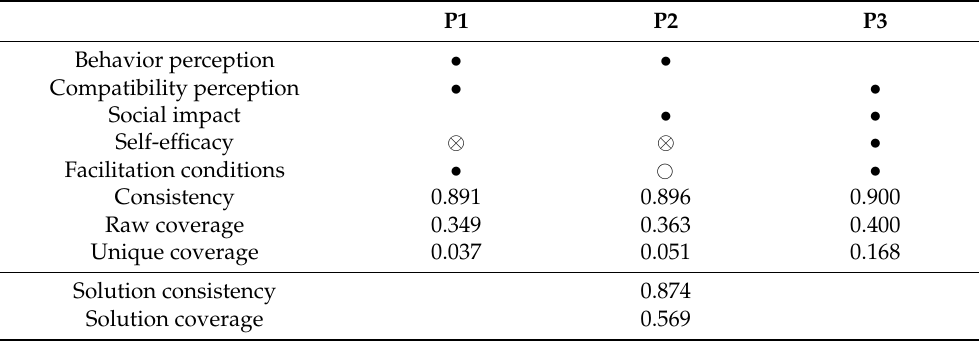
Table 10. Antecedent variable structure of farmers’ adoption